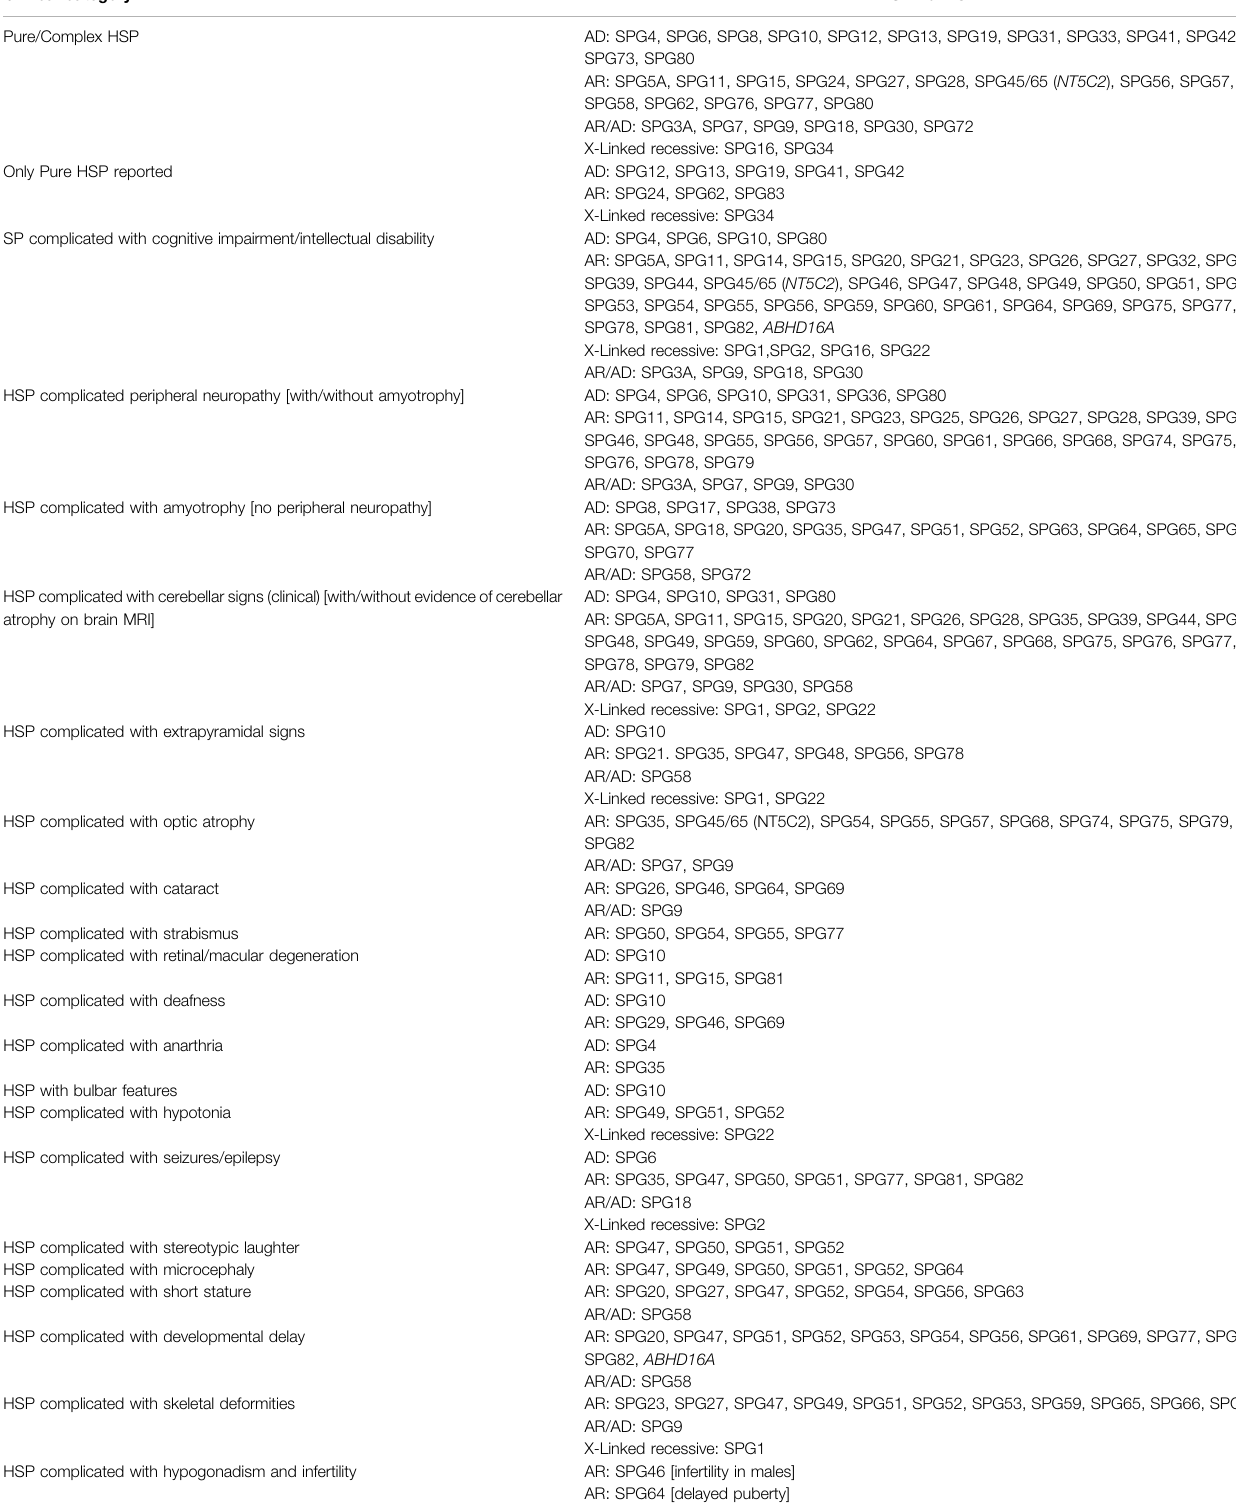
TABLE 2 | Grouping of various HSP forms based on the clinical presentation. Clinical